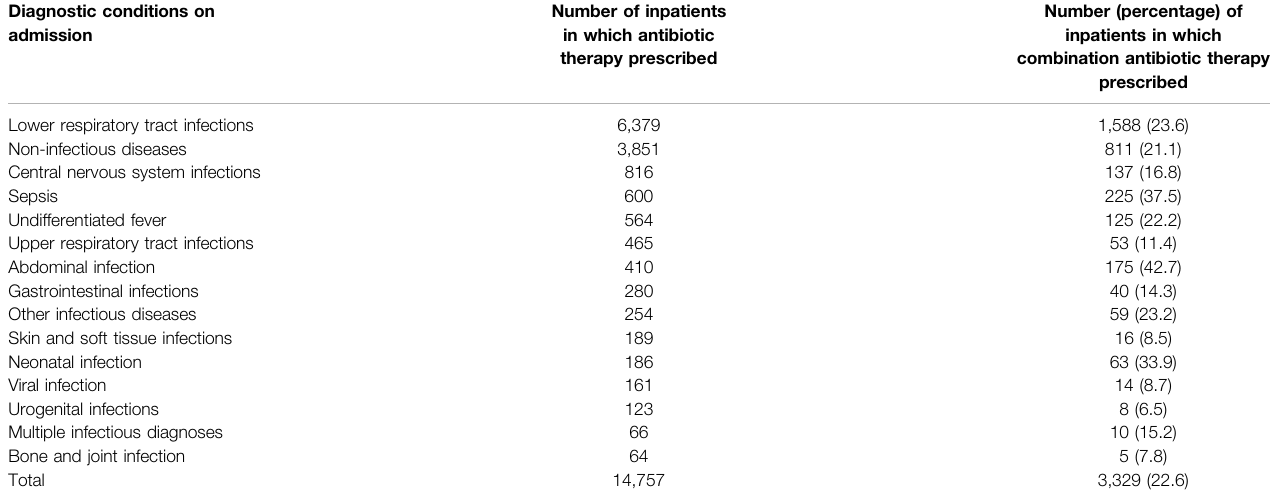
TABLE 3 | Antibiotic prescribing patterns based on diagnostic conditions on admission. Diagnostic conditions on